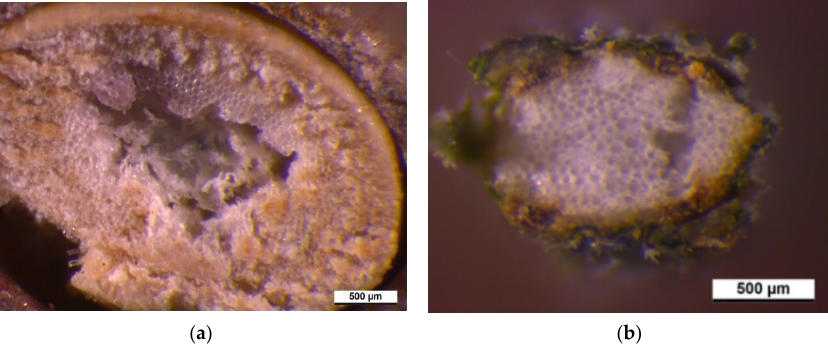
Figure 12. Structure of Miscanthus sinensis ( a ) and Lavandula angustifolia ( b ).